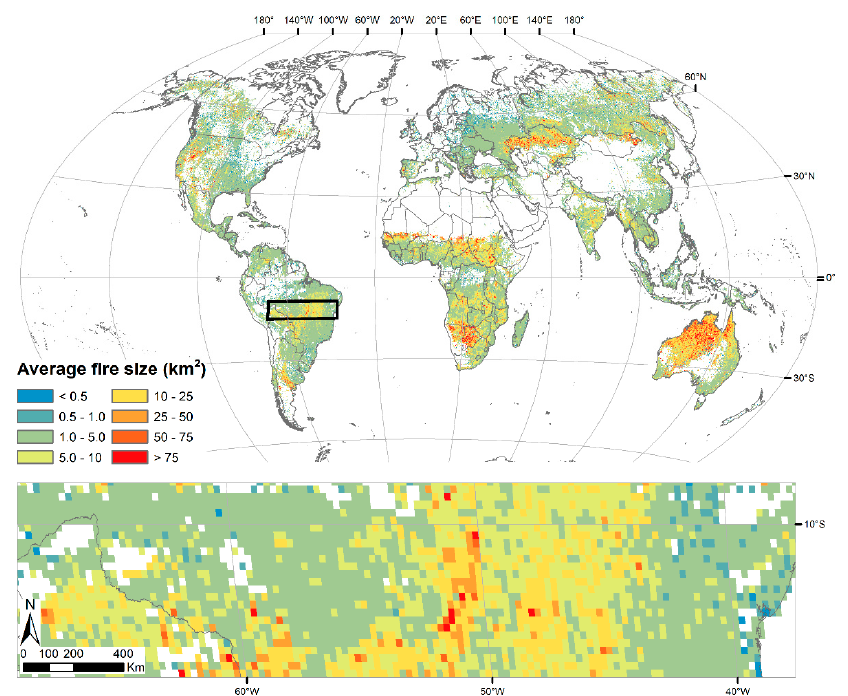
Forests 2022 , 13 , x FOR PEER REVIEW Figure A1. Spatial distribution of the average fire size (see main text for definition and further details). The bottom panel shows a zoomed region in central South America, as delineated in the global map.